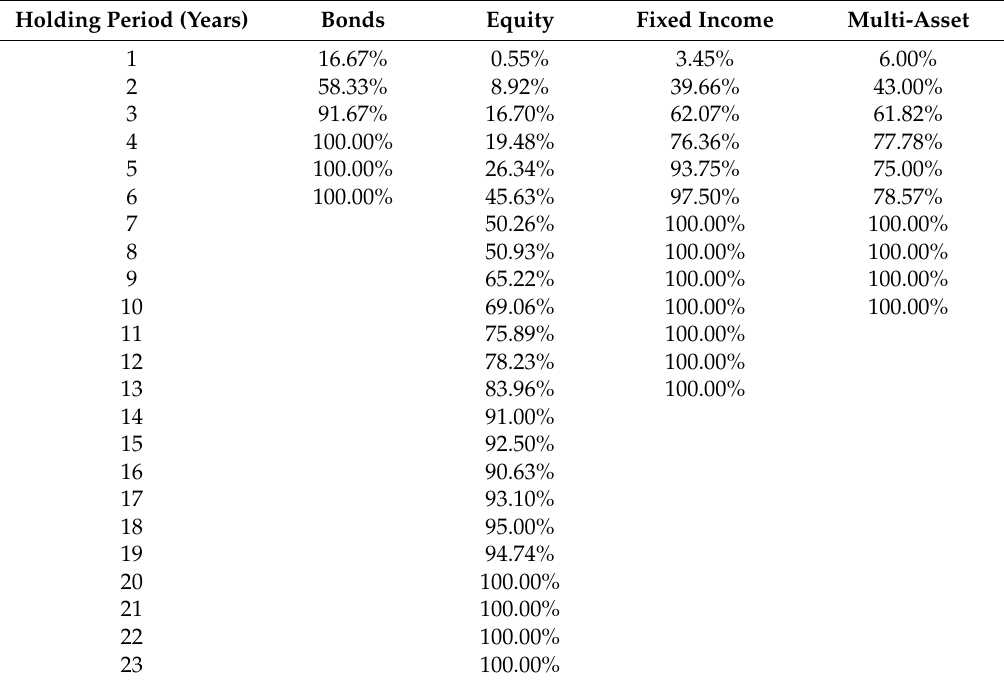
Table 5. NASDAQ Probability of No Loss by Asset